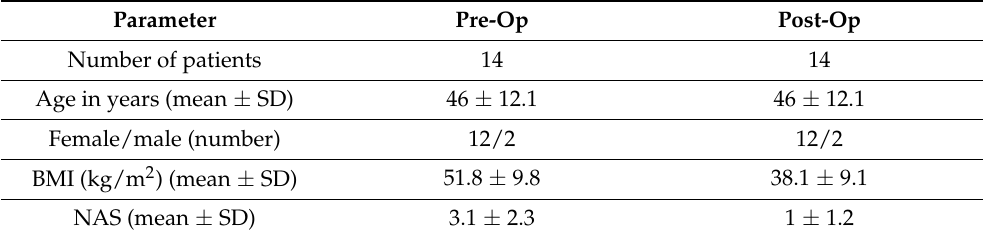
Table 1. Patient characteristics of 14 adipose patients undergoing bariatric surgery (pre-op) and after follow-up